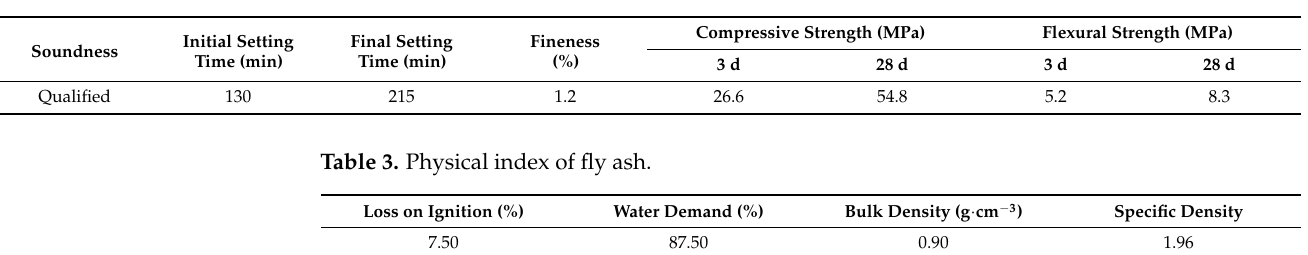
Table 2. Physical and mechanical properties of cement.